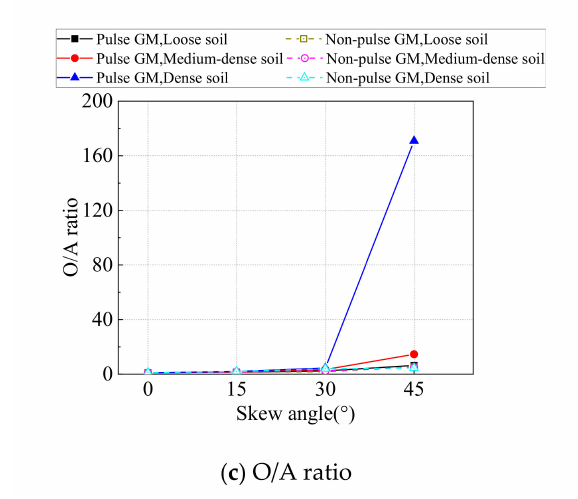
Figure 13. Maximum soil pressure behind abutment.